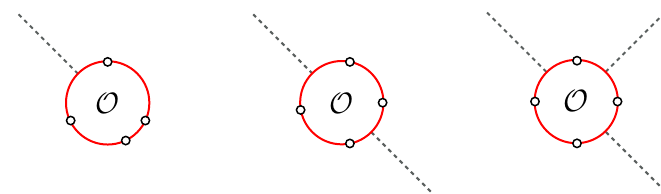
Figure 3 . The divergences triggered by the wrapping e(cid:11)ects are local: they depend on the operator O but not on the details of the geometry it is inserted in, like e.g. the number of times we cut the operator or the way we distribute the magnons on the various subchains. For instance, the three inequivalent cuttings of the operator shown here, corresponding, respectively, to the insertion of the operator in a 2-, 3- and 4-pt function, should develop the same divergences at wrapping order. If we canonically normalize the 2-pt function, then the divergences should cancel out in all the higher point